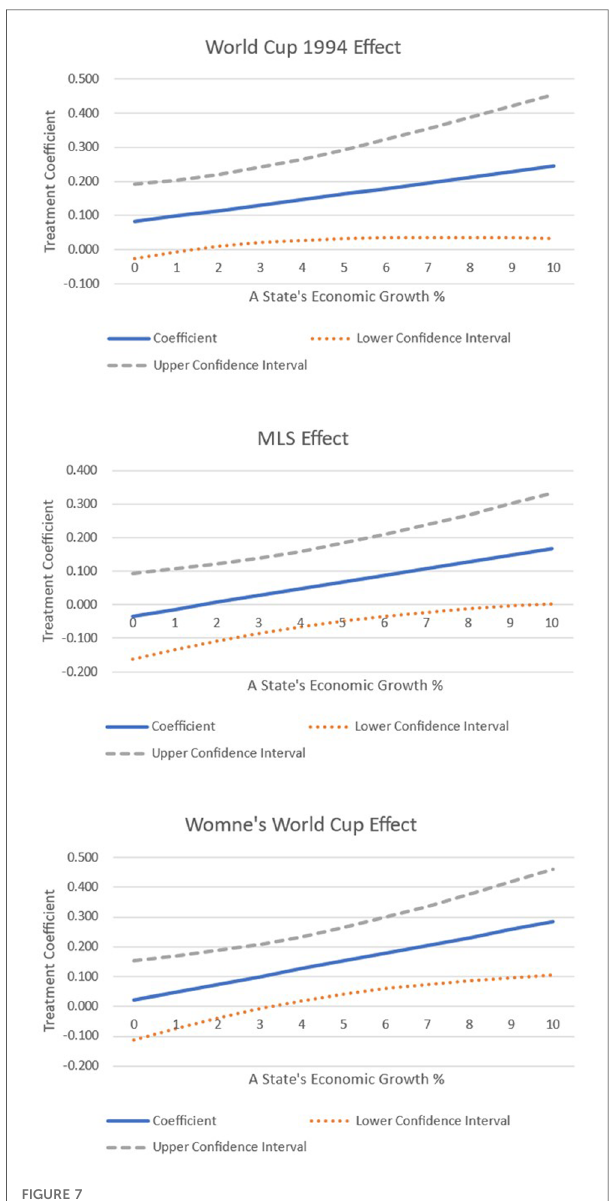
FIGURE 7 Interacting treatment effects with a state ’ s economic growth